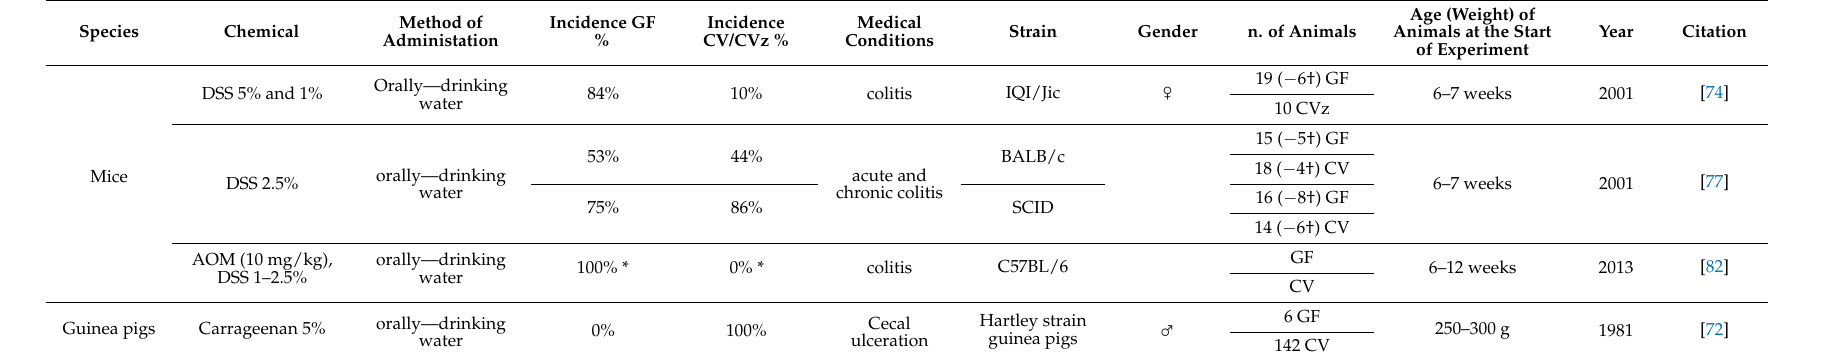
Table 5. Examples of carcinogenesis with AOM and induced colitis in GF